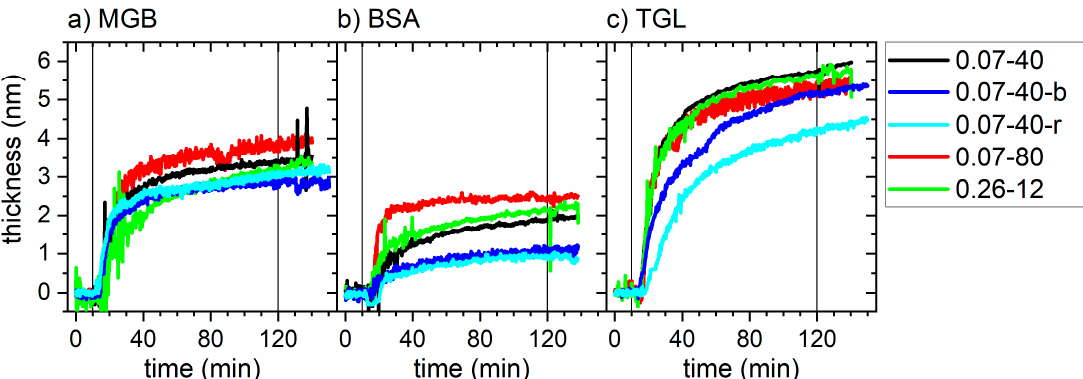
Figure 2. Protein layer thickness for MGB ( a ), BSA ( b ), and TGL ( c ) at the different titanium oxide model surfaces as measured by ellipsometry. The vertical lines indicate the injection of protein-containing buffer solution and the flushing of the flow cell with protein-free buffer, respectively.